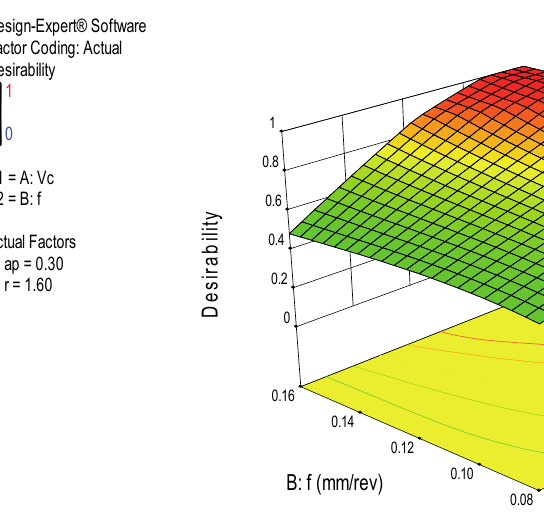
Fig. 12. 3D surface plot for